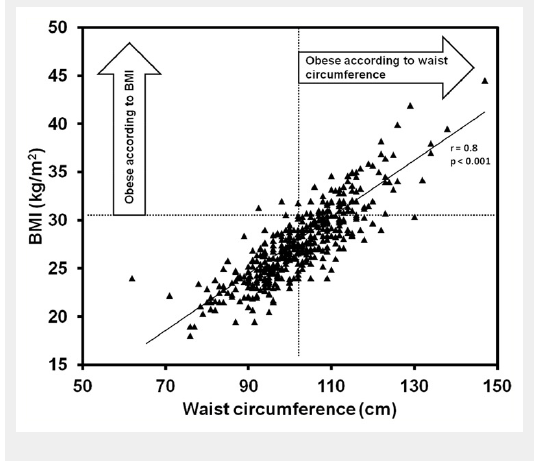
Correlation of waist circumference and body-mass index (BMI).